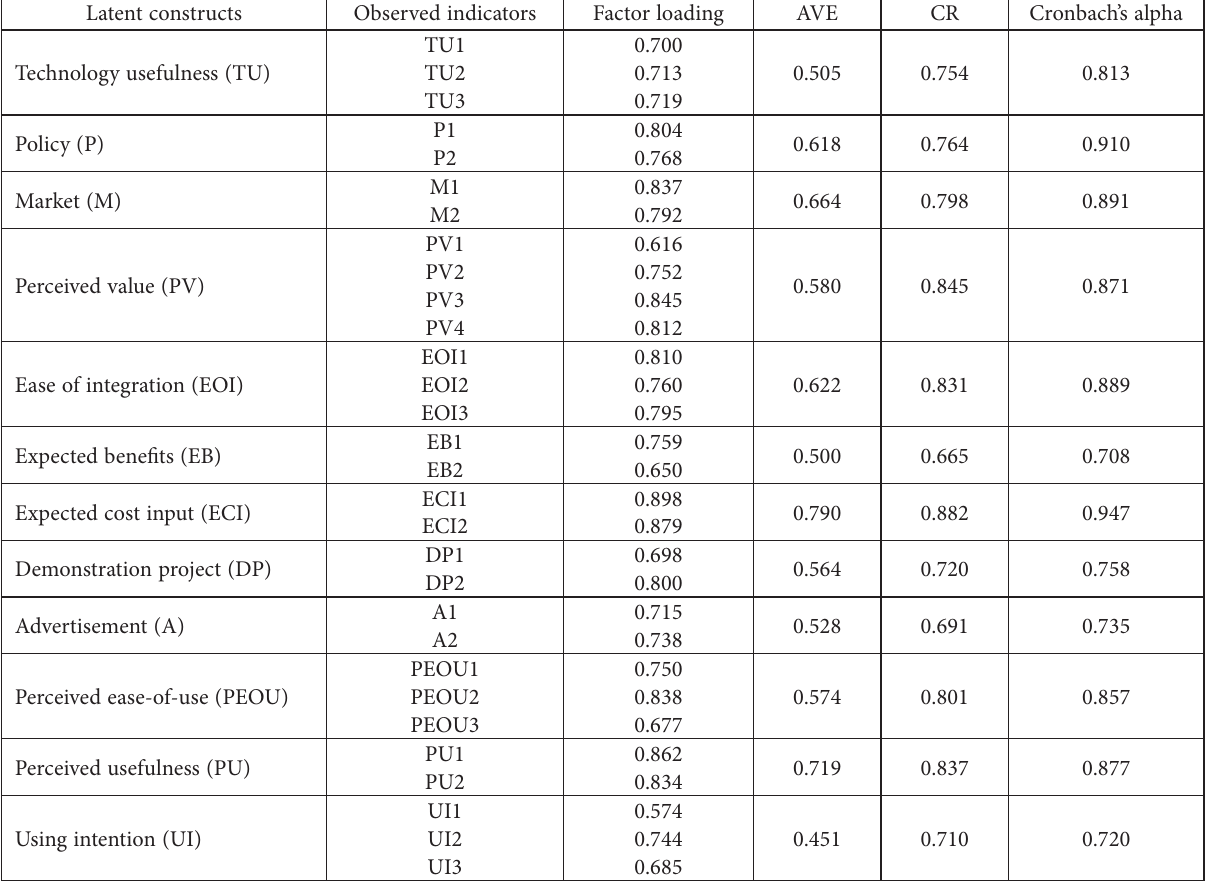
Table 2. Reliability and validity of questionnaire